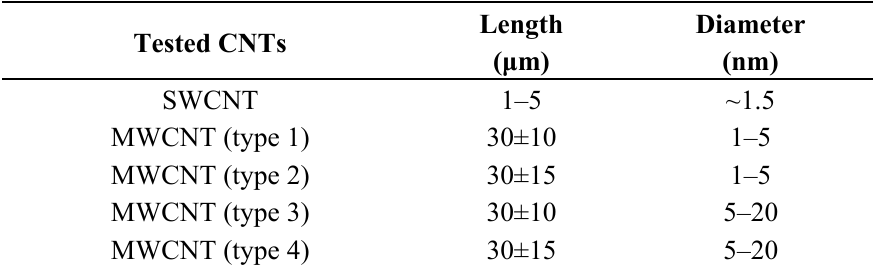
Table 1. Carbon nanotube features.